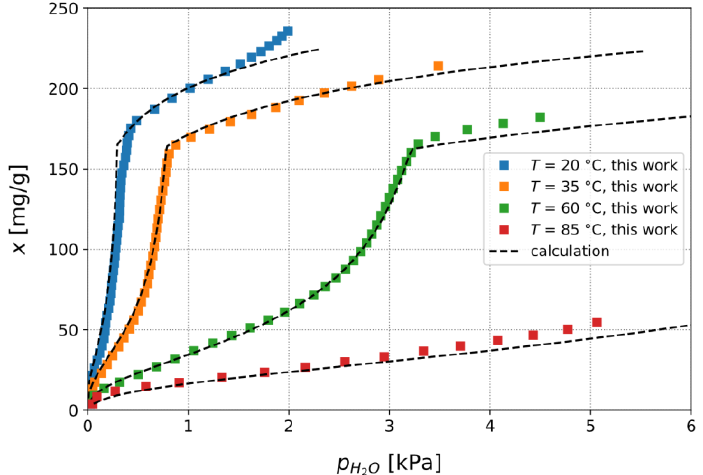
Figure 11. Adsorption isotherms calculated from the potential theory using the characteristic curve from Figure 10 in comparison with the measured isotherms.